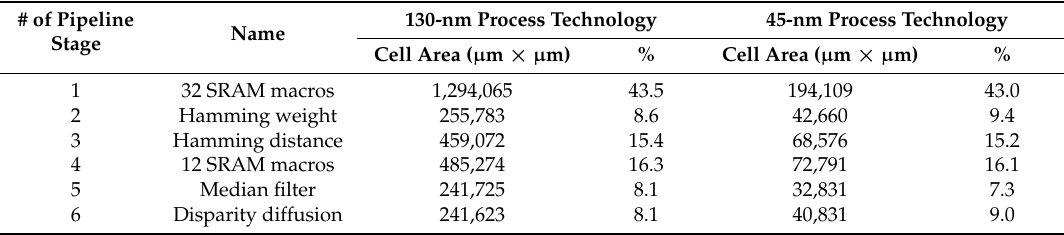
Table 5. Cell area of each pipeline stage of the stereo matching processors designed in 130- and 45-nm